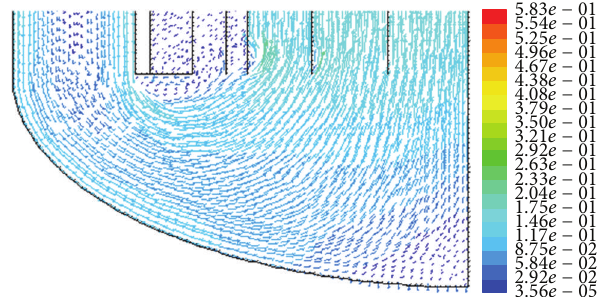
Figure 11: Velocity distribution of lower plenum bottom region.